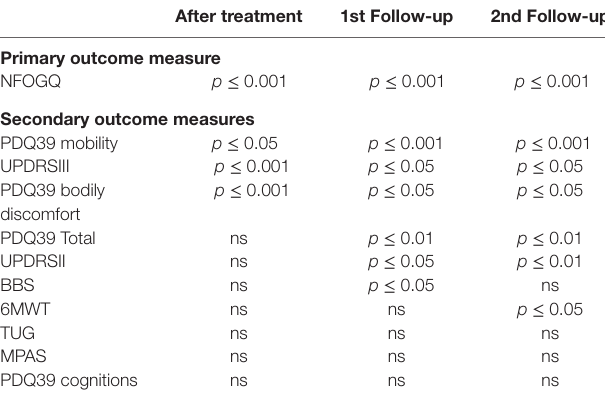
TablE 4 | Bonferroni post hoc comparisons AOS group vs. cue group. after